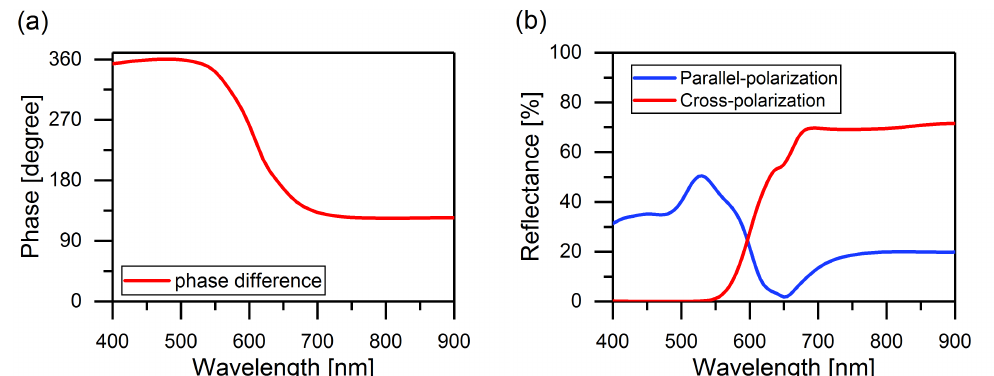
Figure 3. ( a ) Phase difference for reflection from the half-wave plate, with the phase for u-polarized light subtracts the phase of v-polarized light and ( b ) amplitude of circular cross-polarized reflected light, conventional mirror behavior (blue) and co-polarized reflected light, HWP behavior (red) simulated by the software for Multiphysics simulation